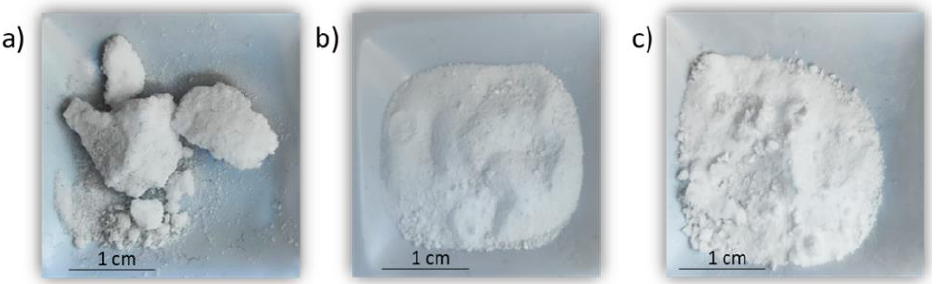
Figure 8. Effect of moisture on physical properties (water absorption) of ( a ) pure NaNO 3 , ( b ) NaNO 3 /SiO 2 NPs (1% wt.) and ( c ) NaNO 3 /Al 2 O 3 NPs (1% wt.).